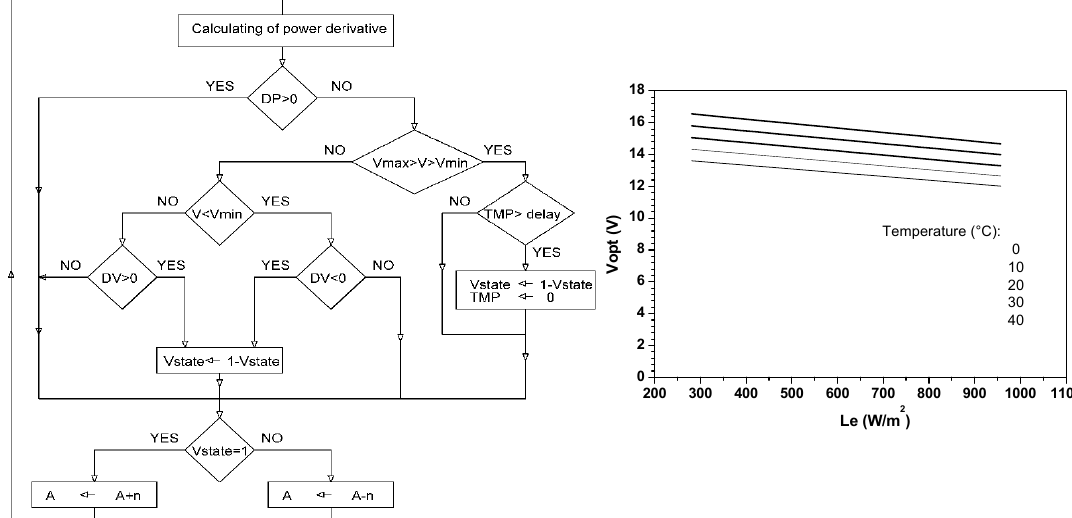
Figure 3. MPPT algorithm and optimal voltage ( V opt) of the photovoltaic voltage (PV) module depending on the lighting and